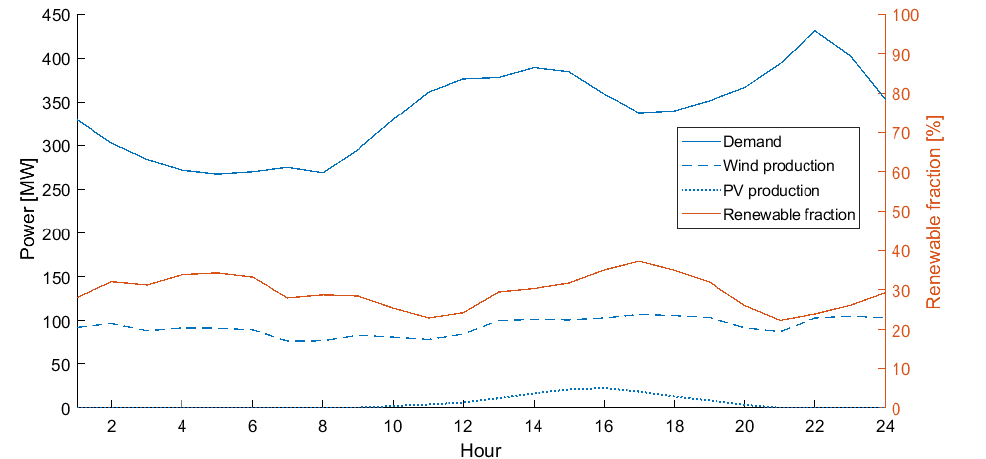
Figure 4. Case 2 demand, wind and PV production, and renewable